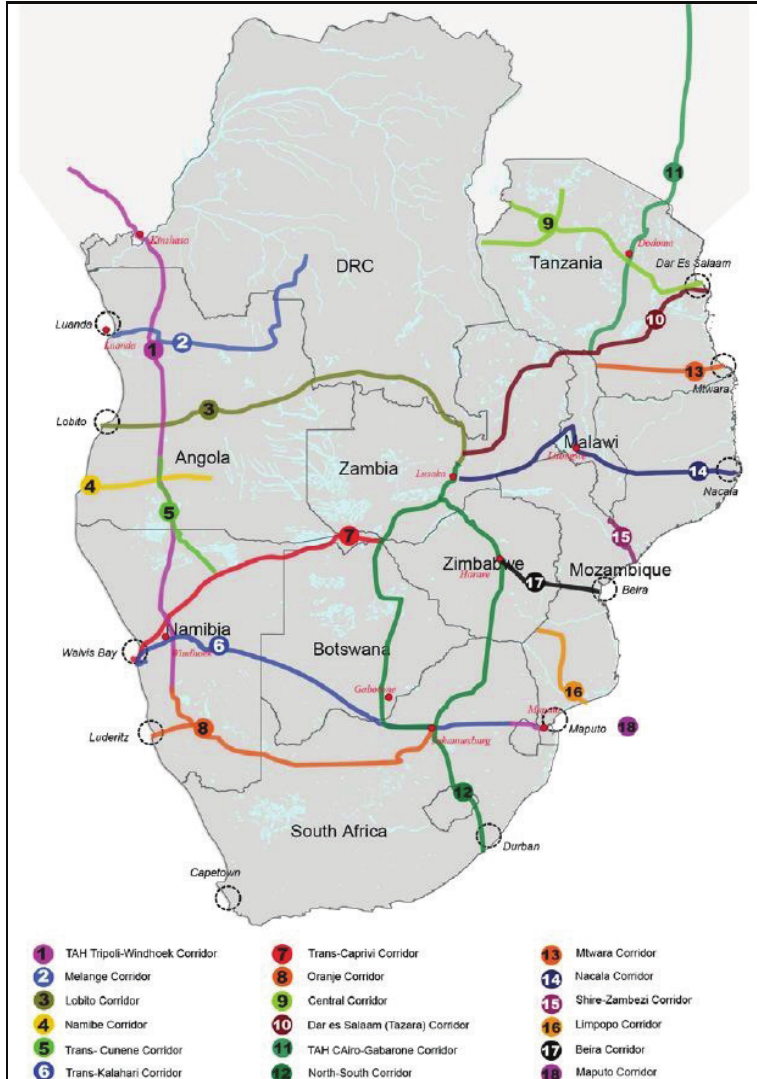
Figure 1: Major intra-regional corridors (JICA, 2010)